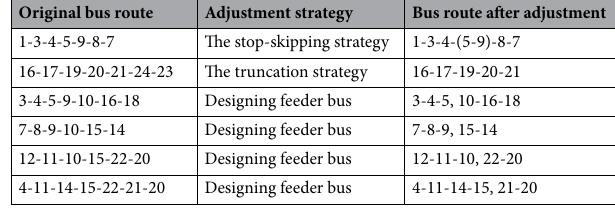
Table 4. Route adjustment schemes. The numbers in parentheses indicate the bus stops that are skipped.